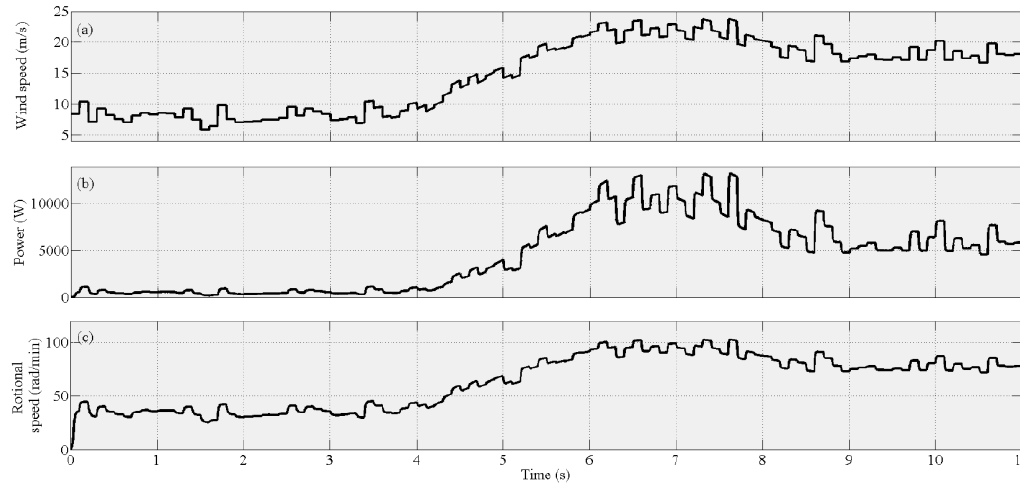
Figure 8. The simulation results of ( a ) the wind speed, ( b ) wind turbine output power and ( c ) rotational speed of wind turbine.